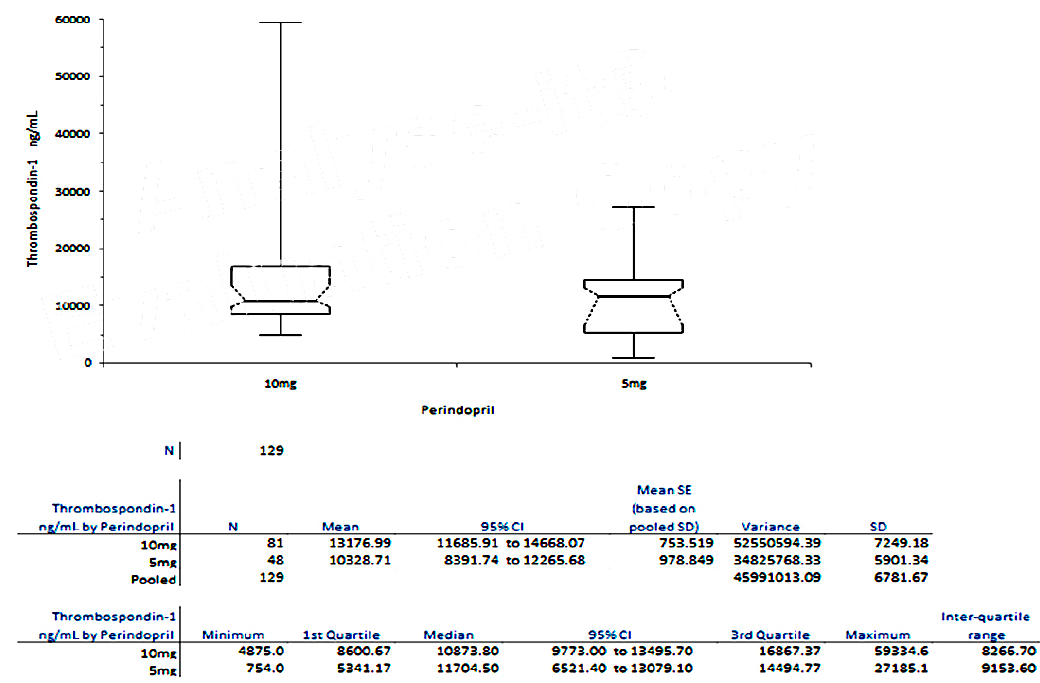
Figure 1. Variation of TSP-1 plasma levels in Group C, under different concentrations of Perindopril. From Figure 2 it can be noticed that women have higher plasma levels compared with men.